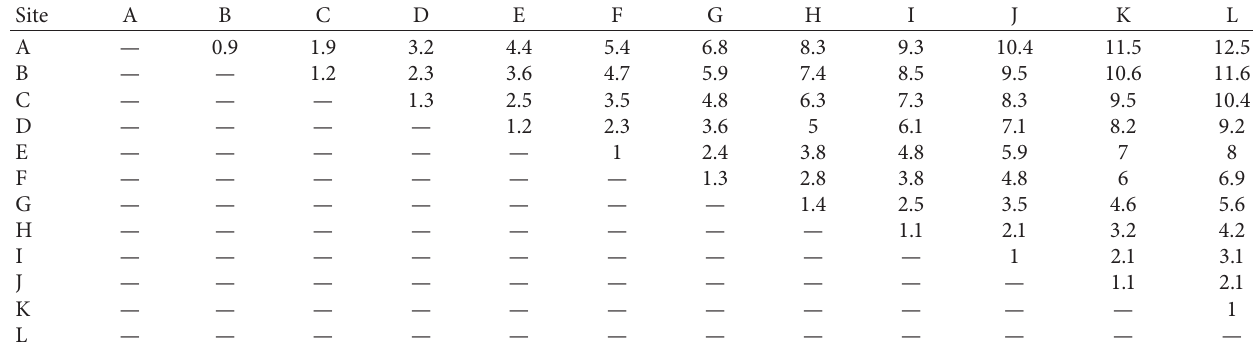
Table 4: Running time matrix between stations